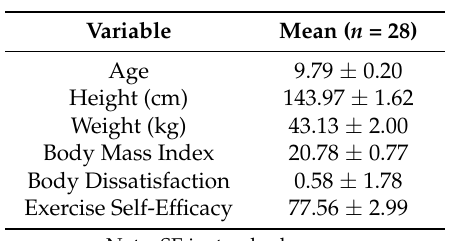
Table 1. Physical Characteristics, BD, and Exercise Self-Efficacy Scores of Latina and Black Children (Mean ± SE).